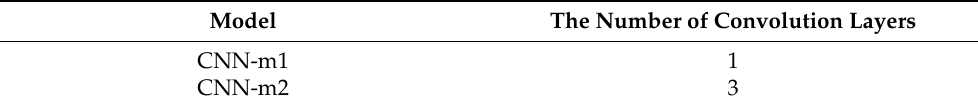
Table 7. Convolution layer settings for the CNN-based anomaly detection models.